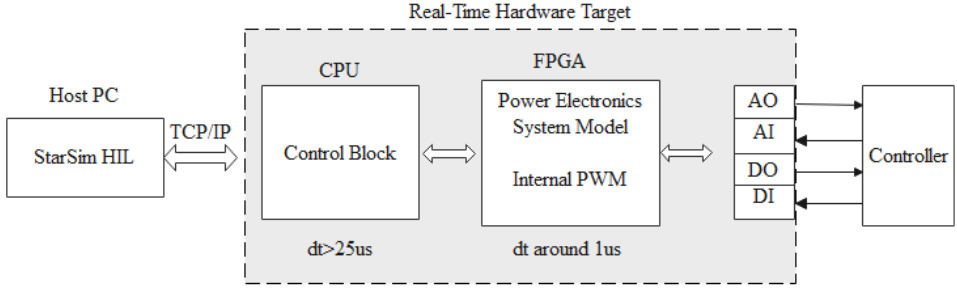
Figure 11. Schematic diagram of HIL.